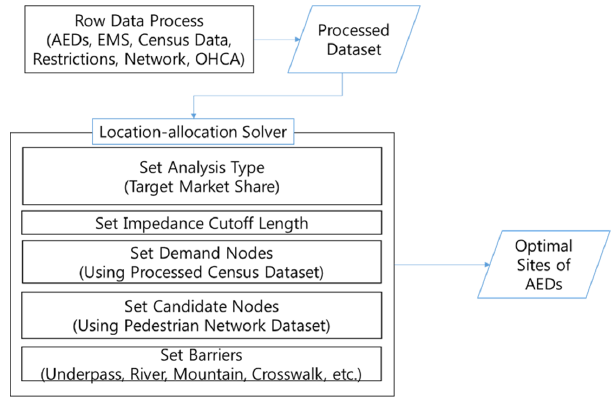
Figure 4. Workflow. AEDs, automated external defibrillators; EMS, emergency medical service; OHCA, out-of-hospital-cardiac-arrest.